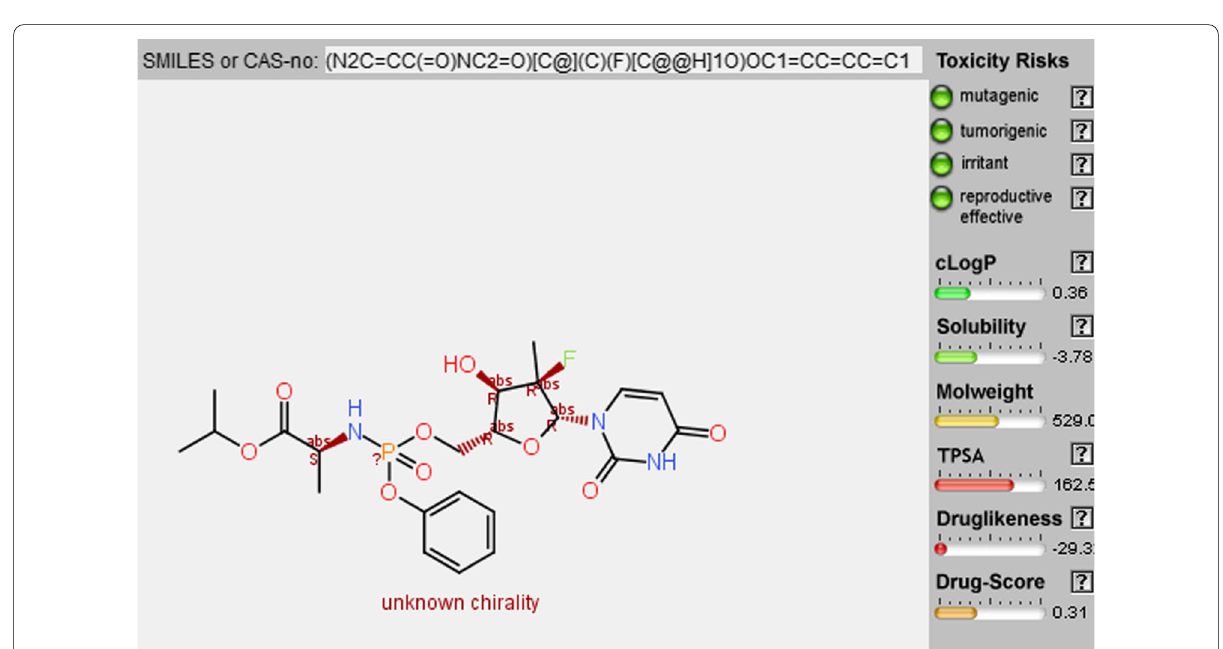
Fig. 7 Side view of the reference molecule on the OSIRIS Property Explorer interface showing physicochemical characteristics including Toxicity